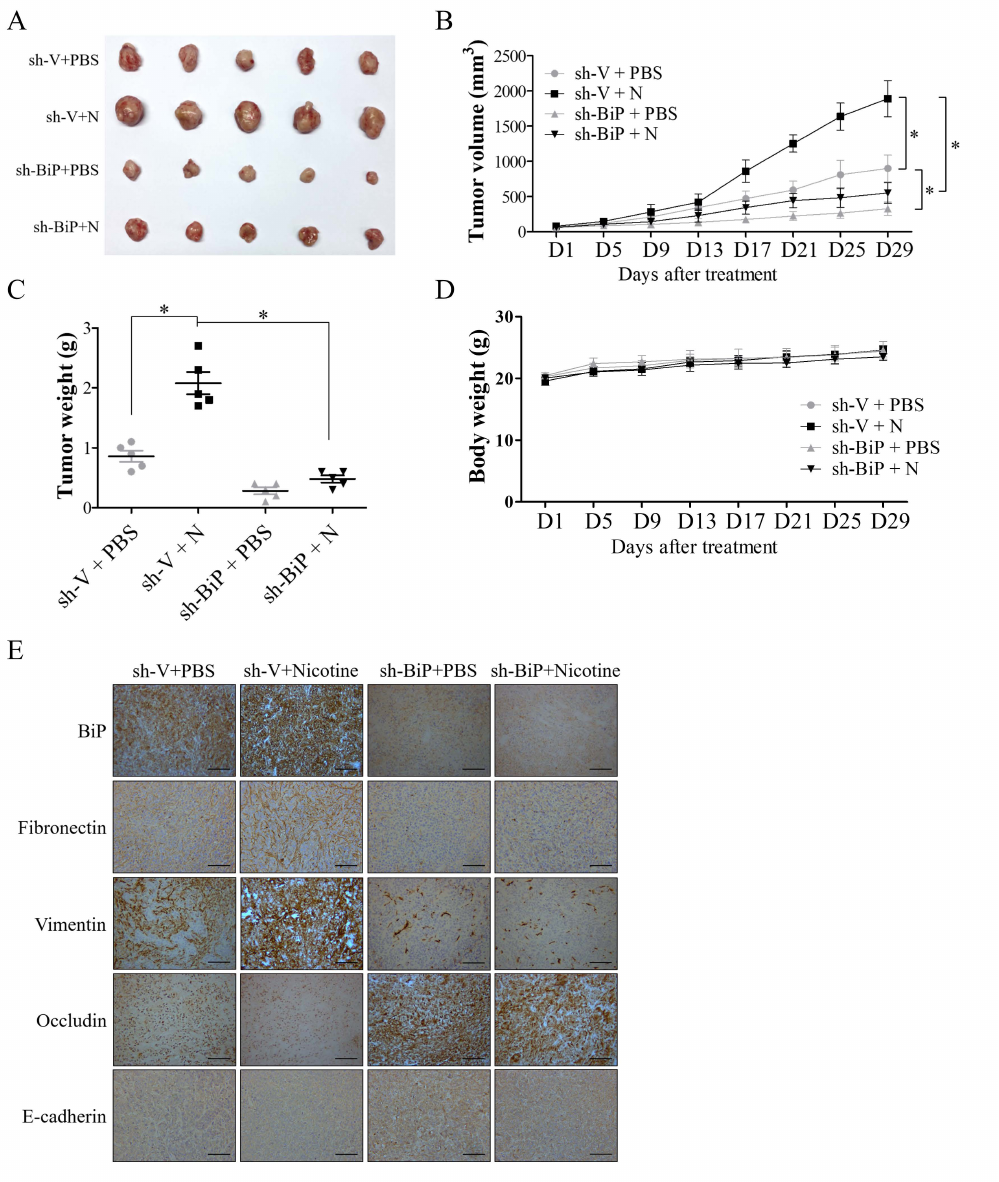
Figure 6. BiP inhibition suppressed nicotine-induced oral cancer progression in nude mice. SAS cells transfected with scramble shRNA control (SAS-shV) or BiP shRNA (SAS-shBiP) (1.5 × 10 6 cells/mice) were subcutaneously